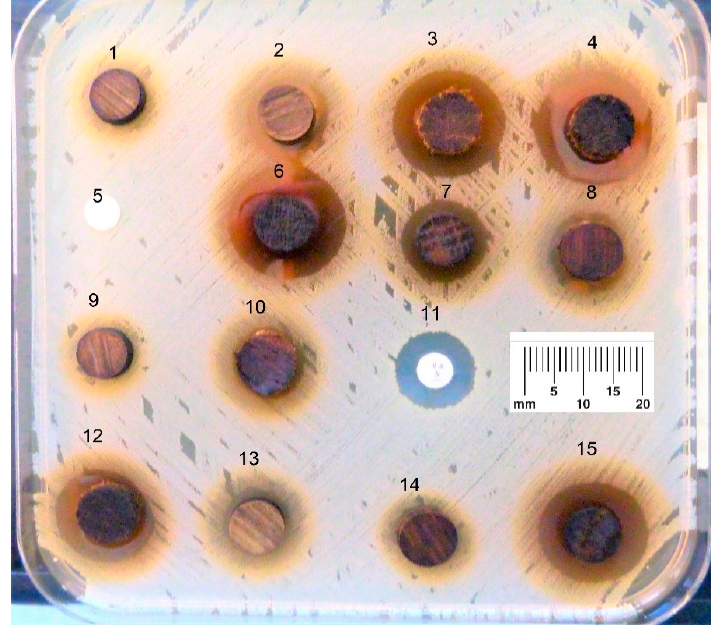
Figure 1. Antibiogram of Staphylococcus aureus streaked on Mueller–Hinton agar plate with oak wood (diameter 9.95 ± 0.1 mm) and control paper discs (diameter 6 mm). (1) Tree 1, laser cut, radial face, autoclaved; (2) Tree 3, laser cut, radial face, gamma irradiated; (3) Tree 2, manual cut, transversal face, gamma irradiated; (4) Tree 1, manual cut, transversal face, non-sterilized; (5) Inert filter paper disc— negative control; (6) Tree 1, laser cut, transversal face, gamma irradiated; (7) Tree 2, laser cut, transversal face, autoclaved; (8) Tree 3, manual cut, radial face, gamma irradiated; (9) Tree 3, laser cut, radial face, autoclaved; (10) Tree 2, manual cut, radial face, gamma irradiated; (11) Vancomycin 5 µg—positive control; (12) Tree 2, manual cut, transversal face, non-sterilized; (13) Tree 1, laser cut, radial face, gamma irradiated; (14) Tree 3, manual cut, radial face, autoclaved; (15) Tree 2, laser cut, transversal face, gamma irradiated; the scale is in millimeters. 2.6. Statistical Analysis Data were analyzed by one-way analysis of variance (ANOVA), followed by measurement of statistically significant differences using Dunnett’s post hoc test (SAS Institute Inc., Cary, NC, USA). All data are presented as the mean ± standard deviation (SD). The results with p < 0.05 were considered statistically significant. 3. Results Antibiosgram results showed that the variation of activity among six trees and three different locations was non-significant ( p < 0.05) in all the experiments (Figures 2 and 3). Tree 1 showed an exception in case of transversal face (lRT and mRT in Figure 3) which had slightly lower activity as compared to the other five trees. The results of the effect of different sterilization techniques on the antimicrobial activity of six oak trees are shown in Figure 2. Autoclaved samples (LA, MA), irrespective of preparation method, had significantly ( p < 0.05) lower antimicrobial activity against S. aureus as compared to non-sterilized (LN and MN) and gamma sterilized samples (LM and MG). There was no significant difference ( p < 0.05) between the activities of non-sterilized and gamma sterilized samples.